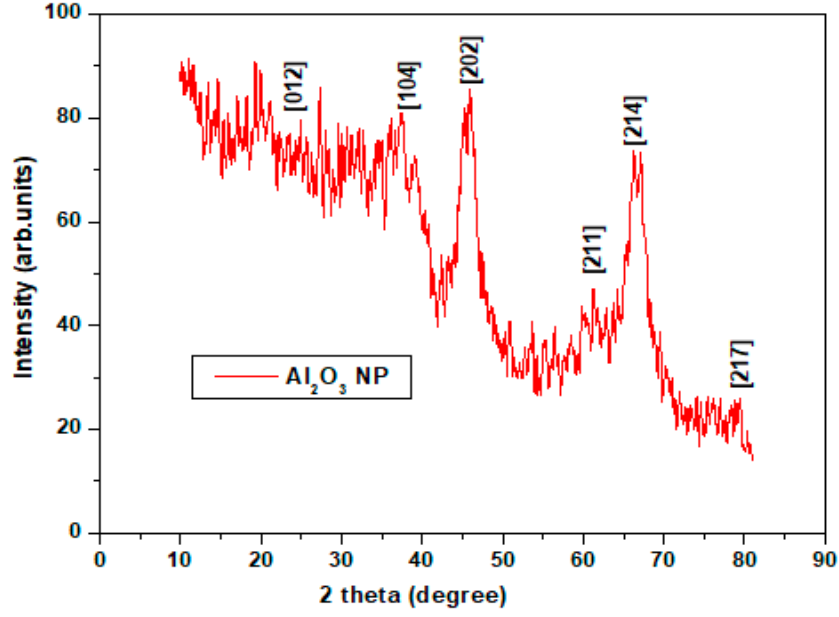
Figure A1. X-ray diffraction pattern of Al 2 O 3 NPs.